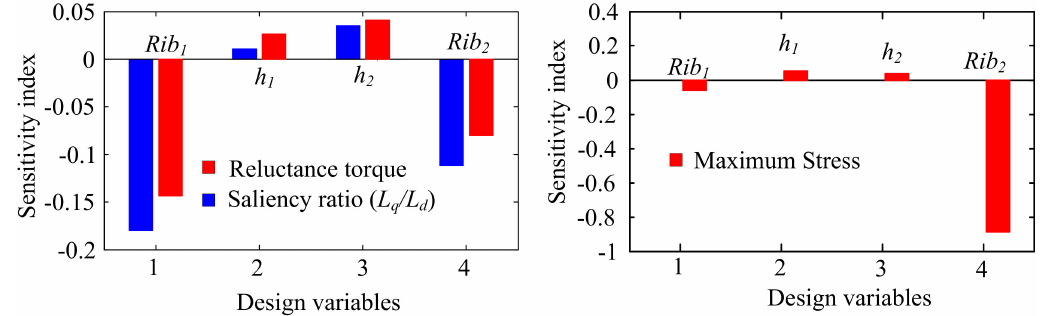
Figure 5. Sensitivity of the design variables on the optimization objectives.